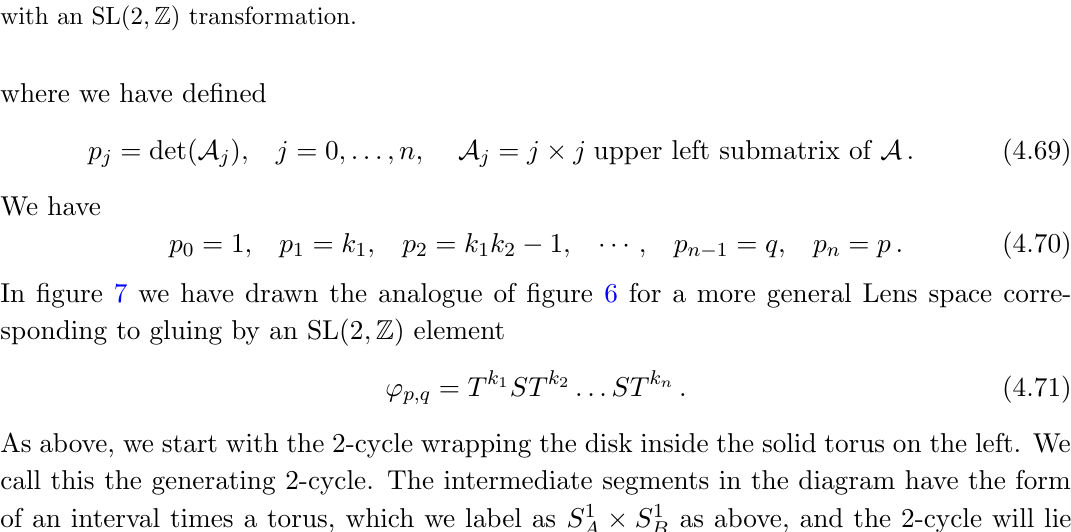
Figure 7 . Heegaard decomposition of L ( p; q ) for linear quiver, where the two solid tori are glued with an SL(2 ; Z )